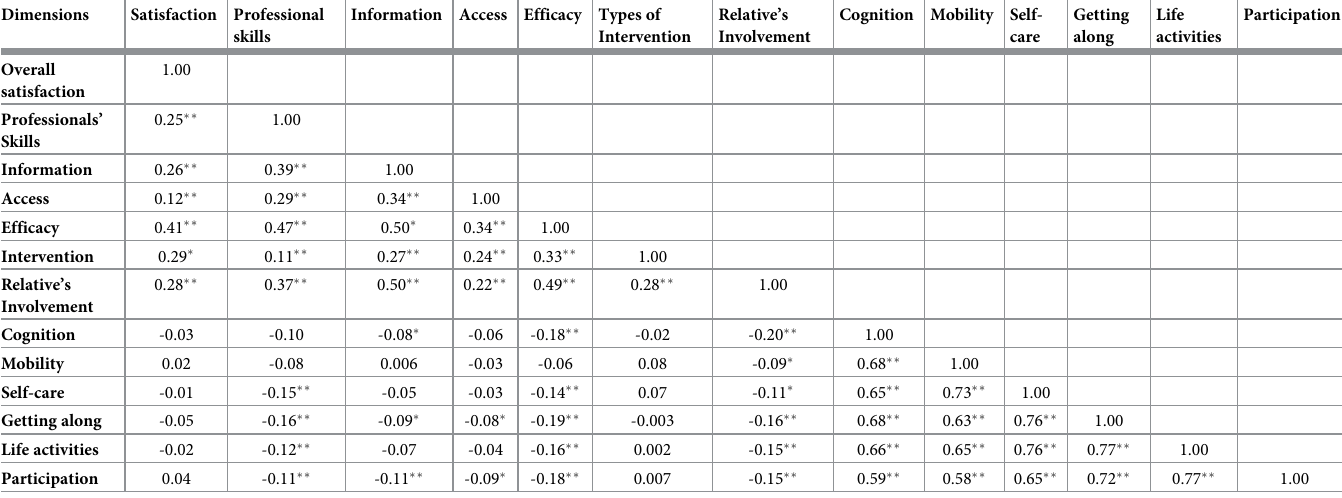
Table 3. Construct validity (convergent and divergent) of quality of mental health instrument (correlation for CFA and SEM